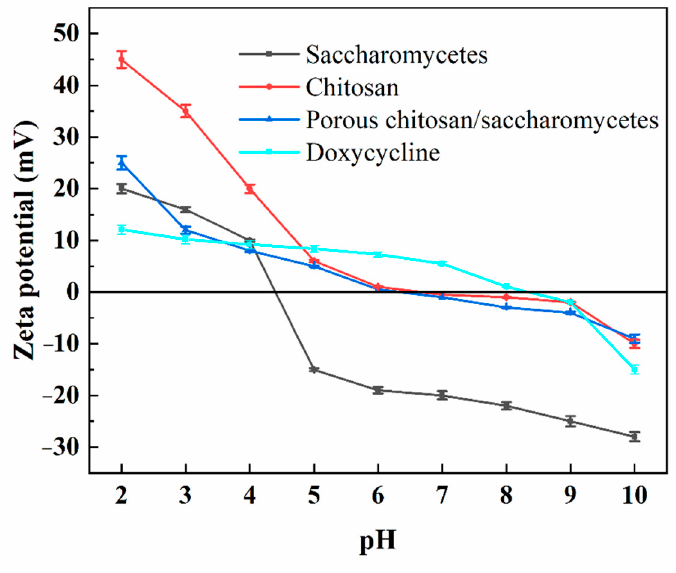
Figure 8. Zeta potential of saccharomycetes, chitosan, doxycycline and the porous chitosan/saccharomycetes microspheres with the ratio of chitosan to saccharomycetes and silica gel of 1:2:3.